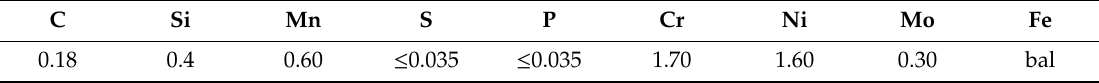
Table 1. Chemical Composition of 18CrNiMo7-6